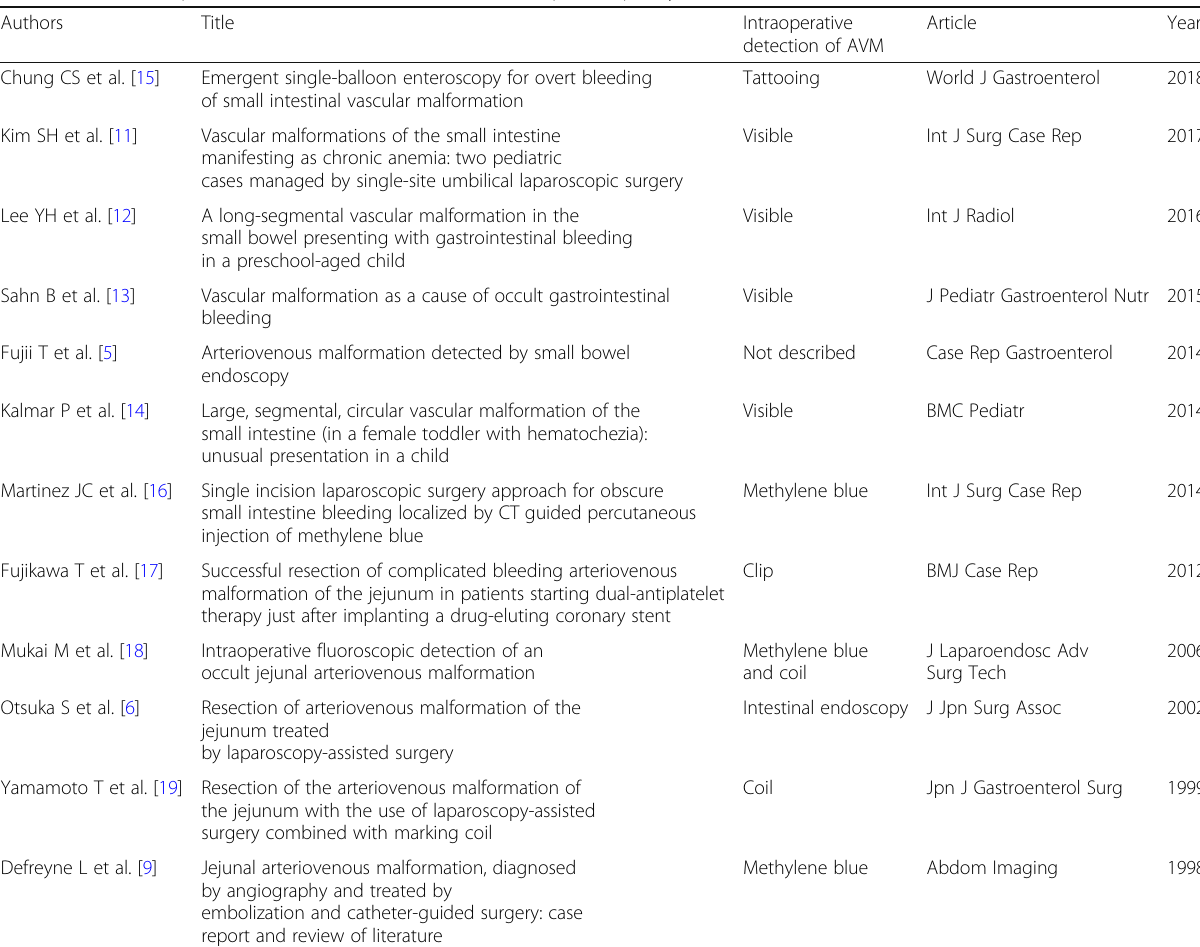
Table 1 Previous reports of small intestinal AVMs resected